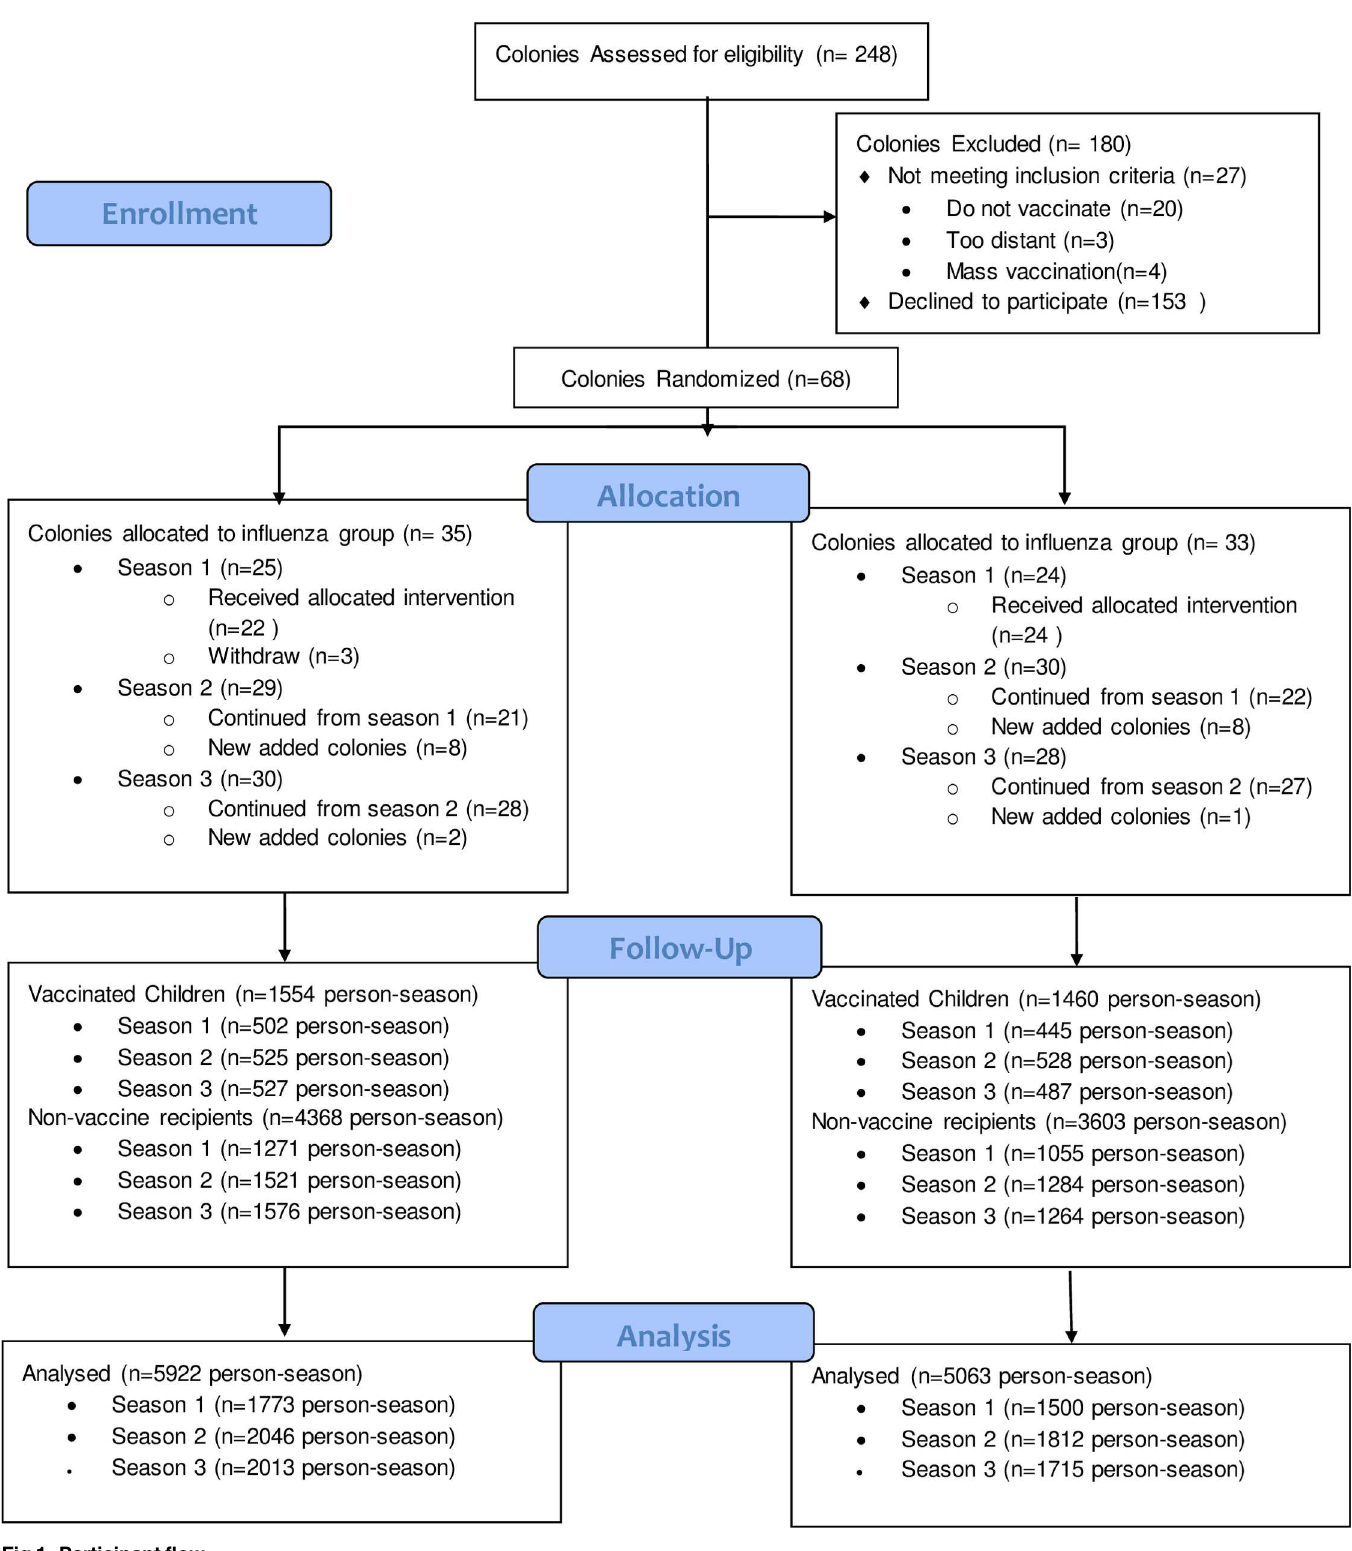
Fig 1. Participant flow.